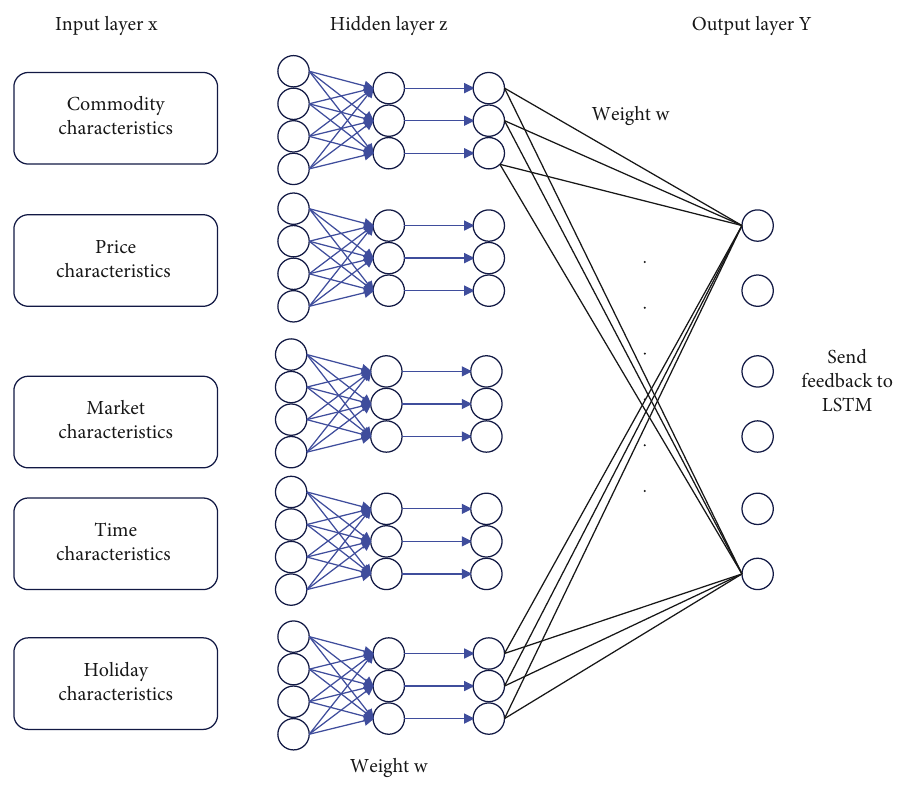
Figure 7: The structure of the association layer of the AR-MDN model.